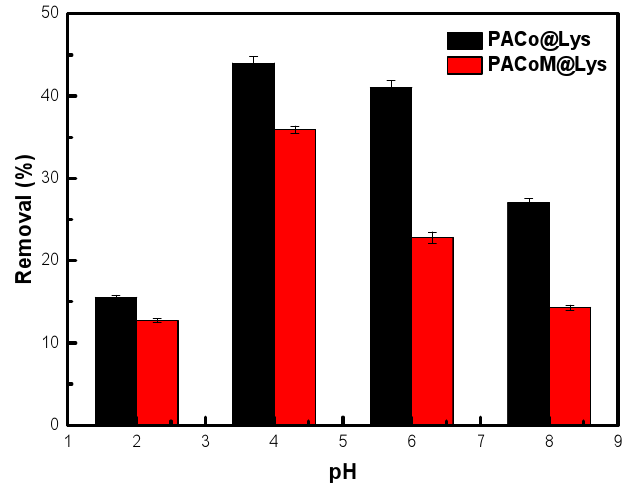
Figure 8. pH dependence of ASA adsorption by the nanoadsorbents.